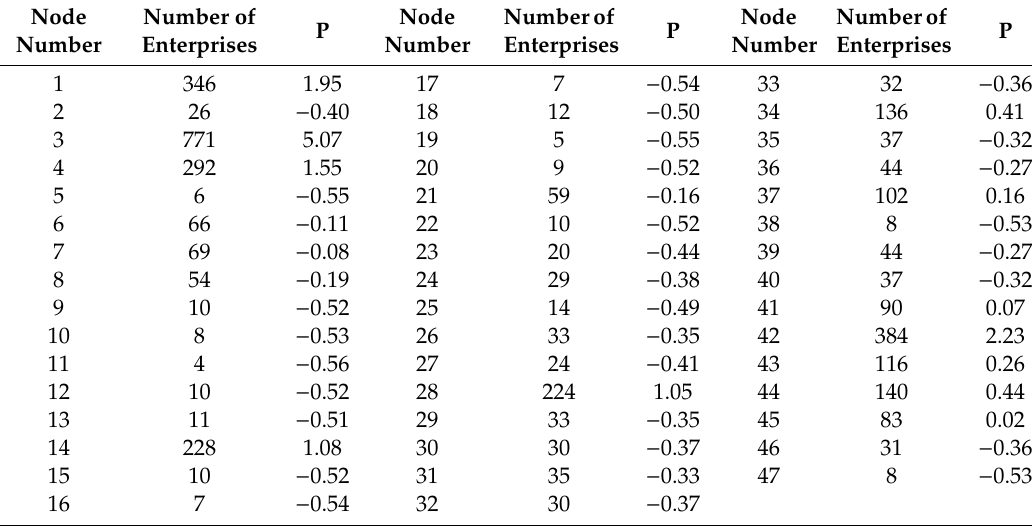
Table 10. Analysis of freight volume.